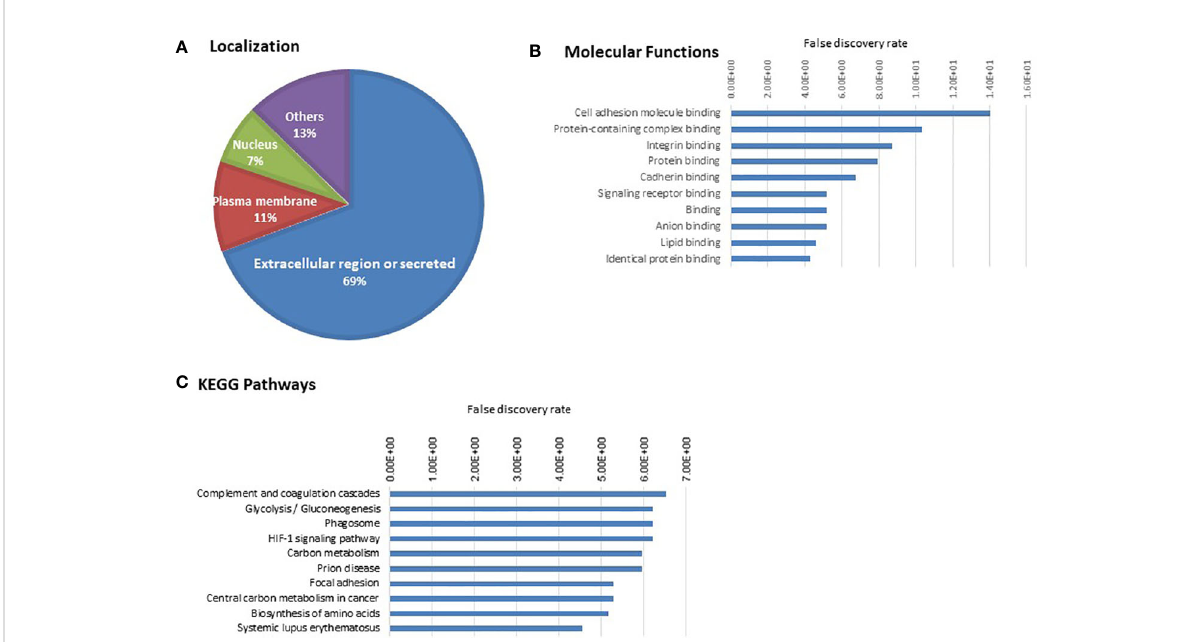
FIGURE 3 Gene ontology analysis of 110 cell line-derived EV proteins. (A) Localization (B) Molecular Function (C) KEGG pathways. The proteins associated with the top 10 molecular functions and pathways are provided in Supplementary Tables S5A and